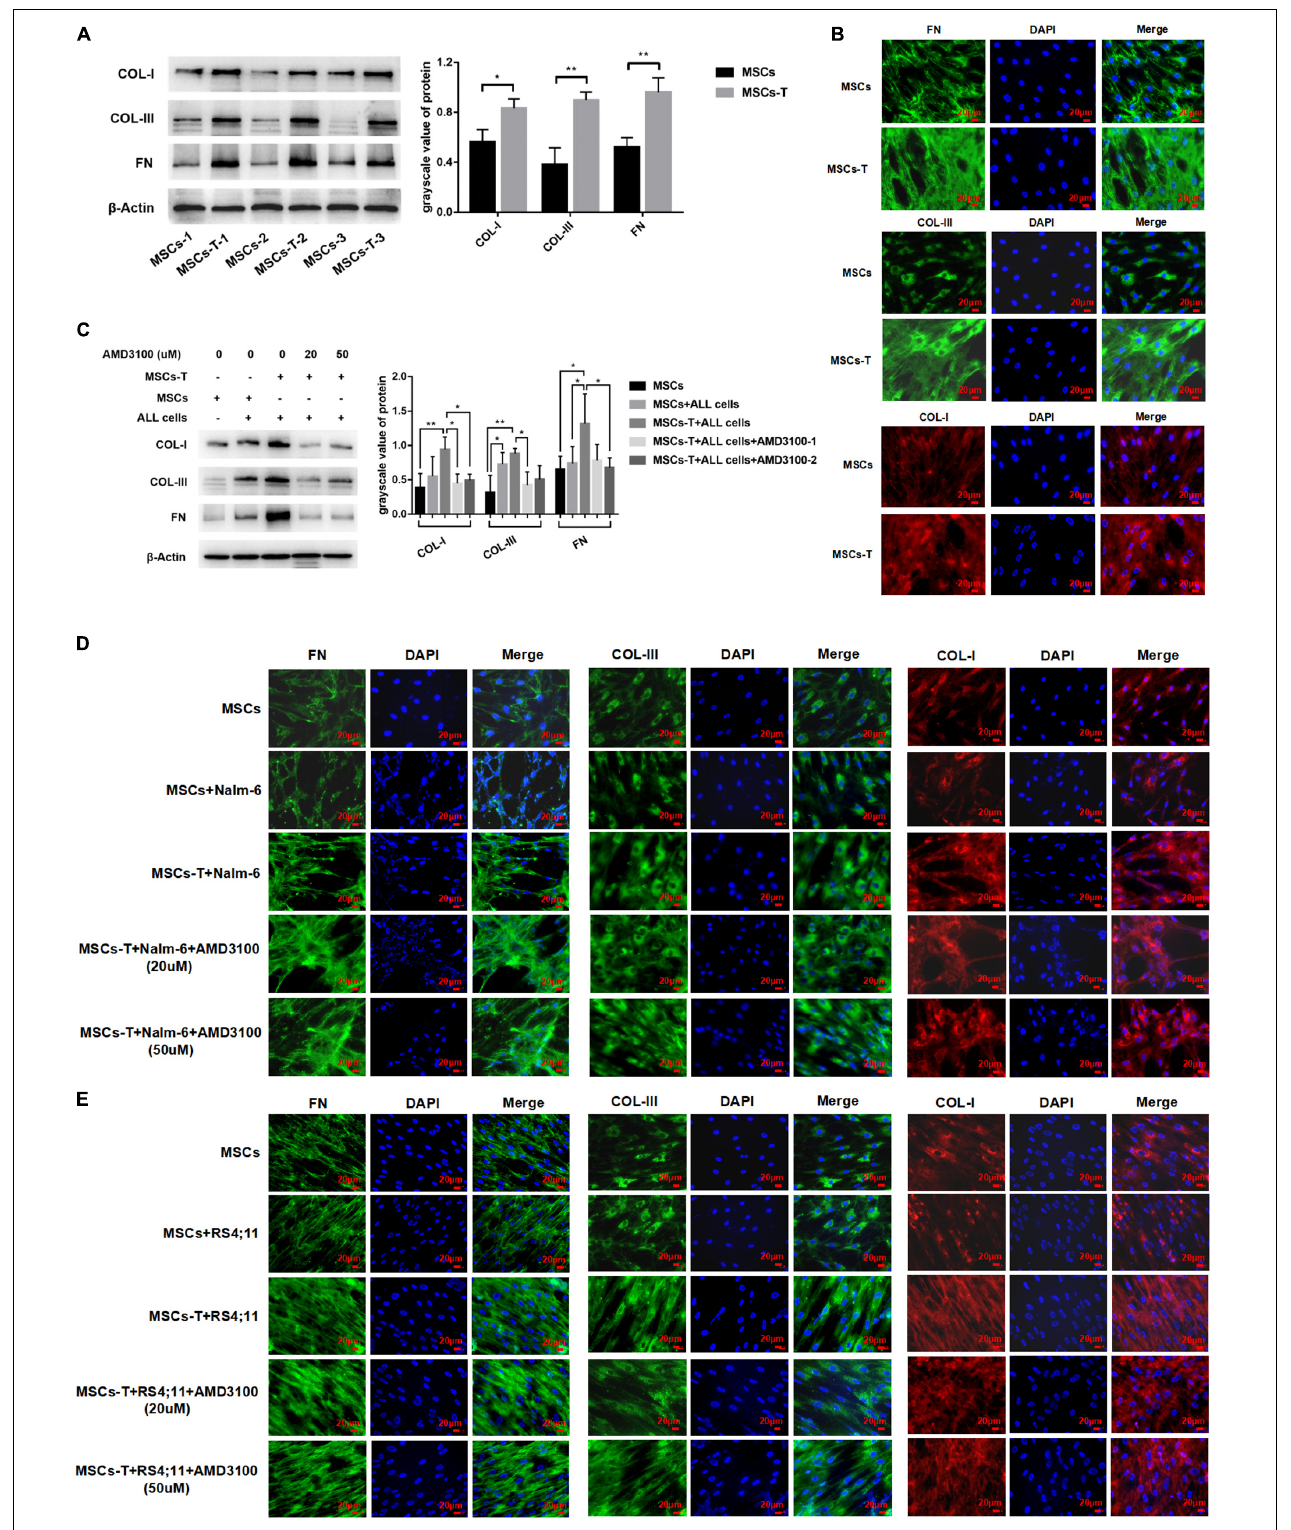
FIGURE 5 | Mesenchymal stem cells with CAF-like phenotype secreted enhanced extracellular matrix protein to promote the adhesion of leukemia cells, but AMD3100 cannot effectively reverse the increased matrix protein. (A) The expression of Collagen-I (COL-I), Collagen-III (COL-I), and Fibronectin (FN) in MSCs ( n =